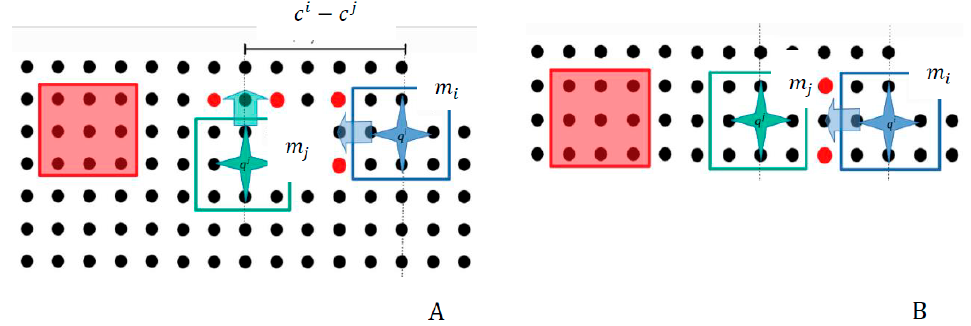
Figure 19. Study of the constraints for the parallel motion of two microparts. ( A ) the distance between the microparts seems sufficient; ( B ) finally the activation for m i influences the motion of m j .